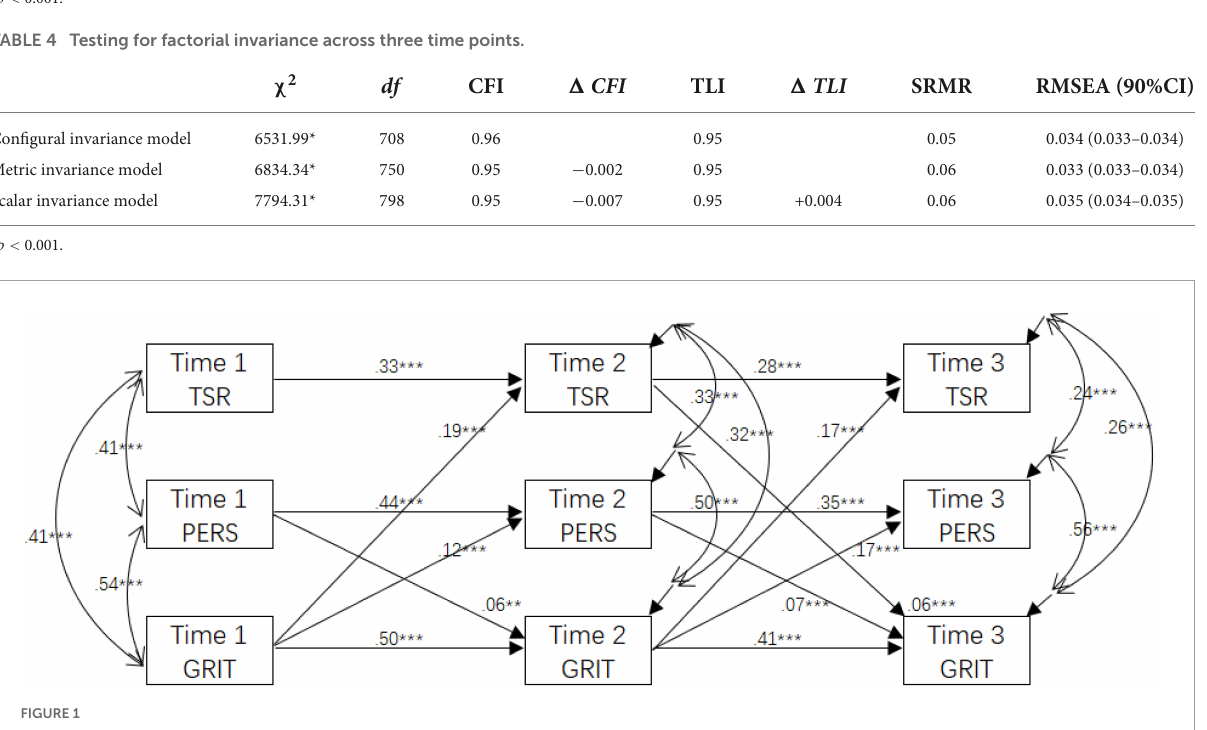
( β = 0.06, p < 0.01, small effect size). However,